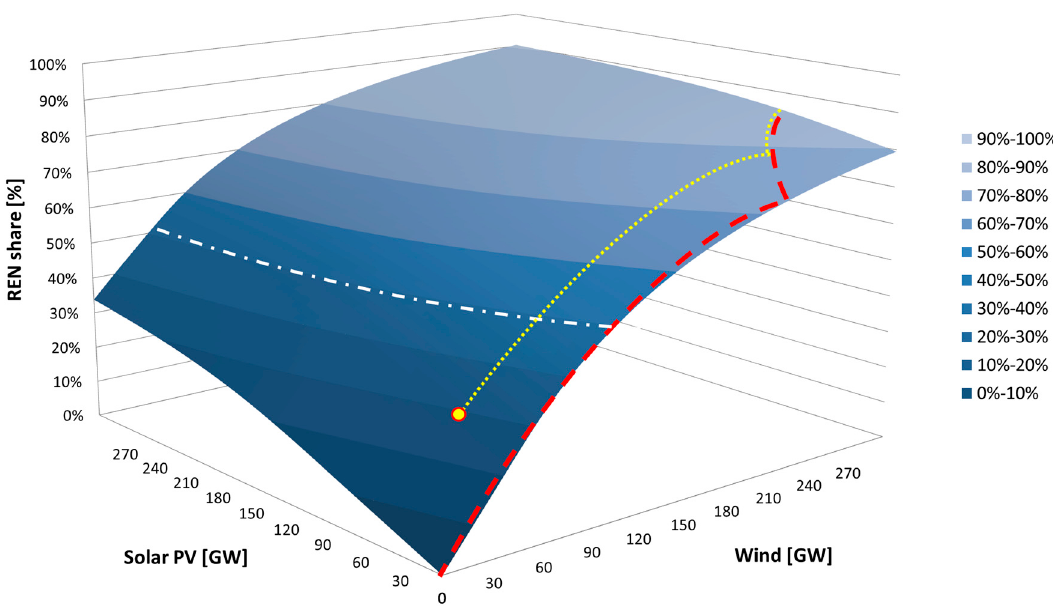
Figure 10. REN share surface plot and efficient pathway for Case AS, including the efficient pathway starting at 0 GW wind and solar PV deployment (dashed line), the efficient pathway starting at the 2017 capacities for wind and solar PV (dotted line), and the 50% REN share marking for various combinations resulting in a 50% REN share (mixed dotted-dashed